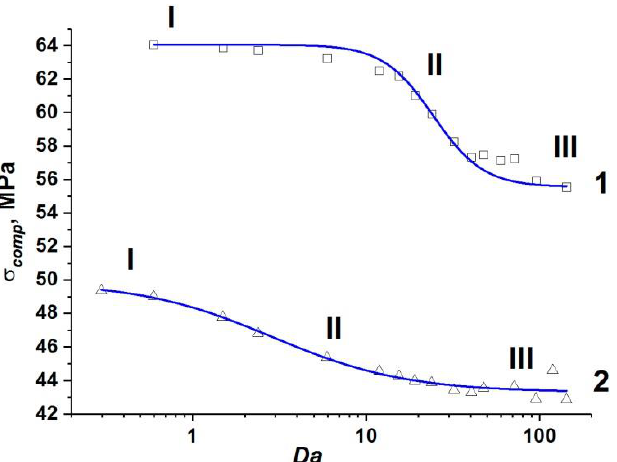
Figure 3. Dependence of the compressive strength of fluid-saturated mesoscale concrete samples with one-scale (curve 1) and two-scale (curve 2) pore structures on the Darcy number Da . Three main sections are marked on the curves: the characteristic fluid flow times are much shorter than the characteristic loading times (I); a qualitative change in the balance of these competing processes (II); the characteristic fluid flow times are much longer than the characteristic loading times